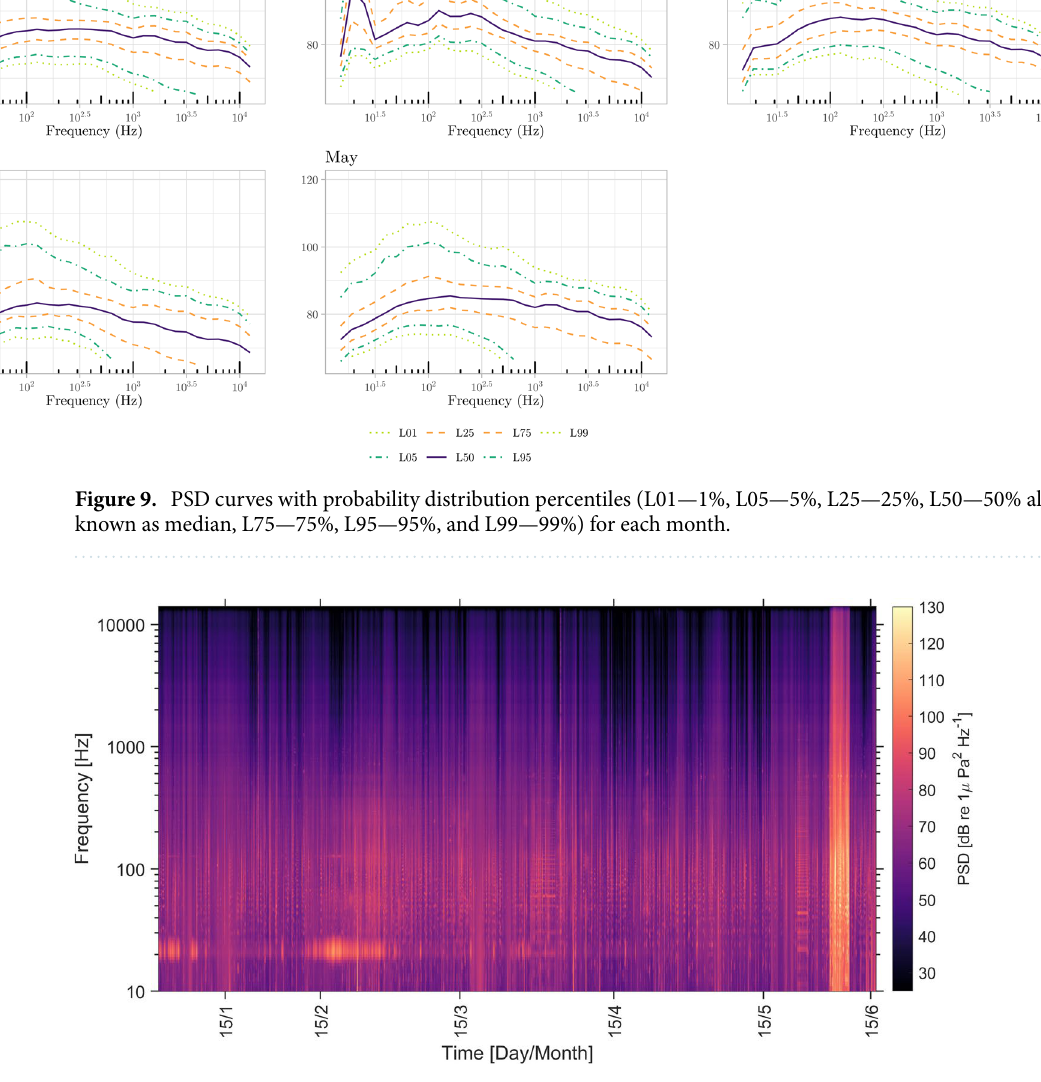
Figure 10. Long-term spectral average (LTSA) plot for the study period, calculated in Matlab following Merchant (2015) with a frequency resolution of 1 Hz and time-averaged over 10 s using the Welch method. Frequency is displayed in log form on the